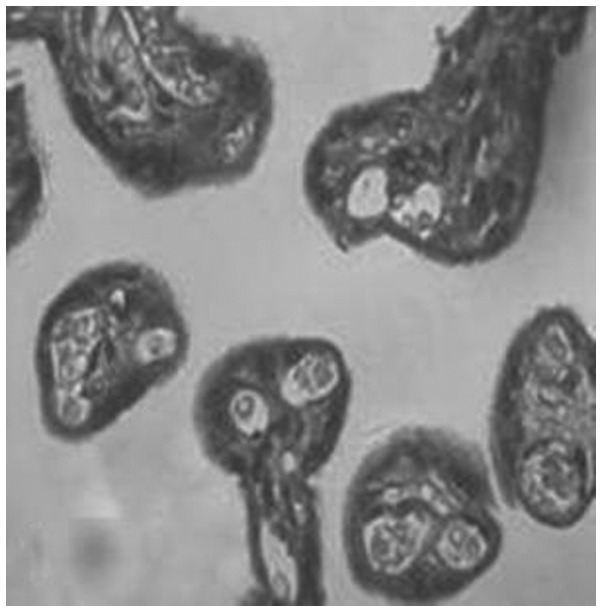
Immunohistochemical staining for matrix metalloproteinase-1 in a normal placenta. Magnification, ×400.